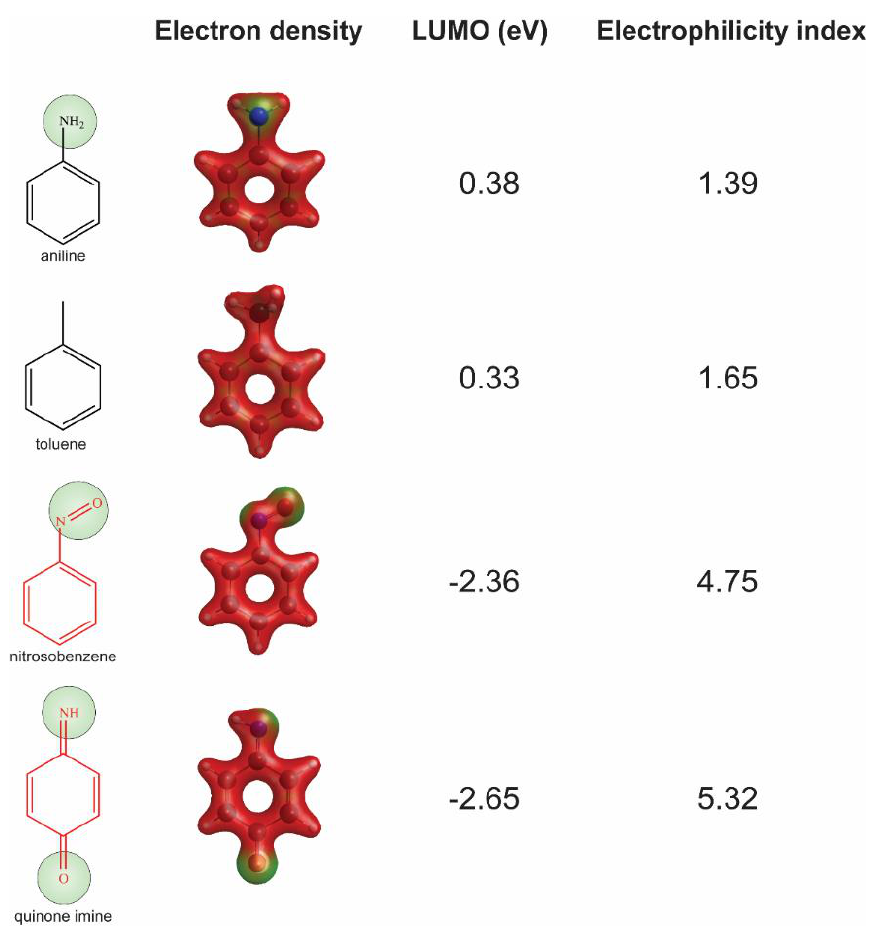
Figure 3. Assessment of reactivity of aniline, nitrosobenzene, quinone imine, and toluene by quan- tum chemistry analysis. Low electron density areas are shown in green, indicating the potential electrophilicity of the